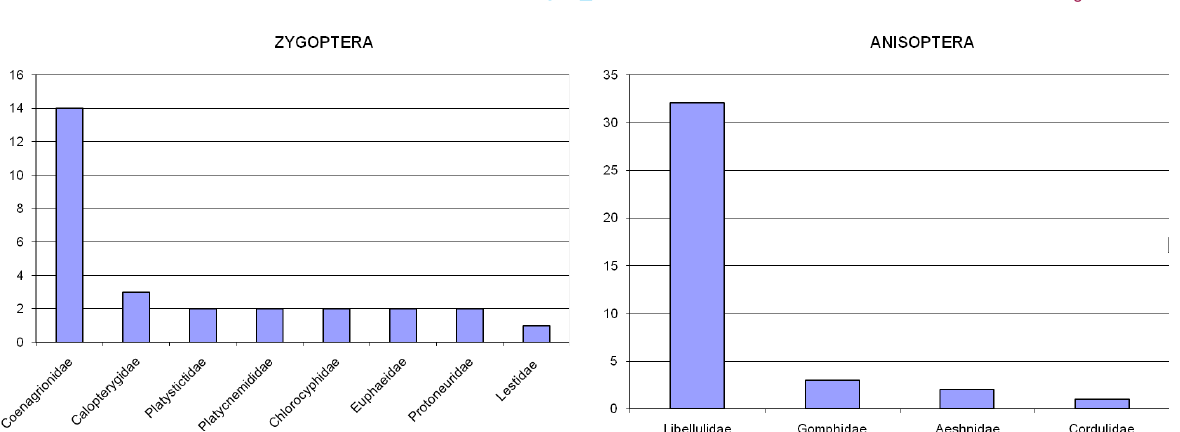
Figure 1. Family contribution under Sub-Order Zygoptera to odonate diversity of Goa